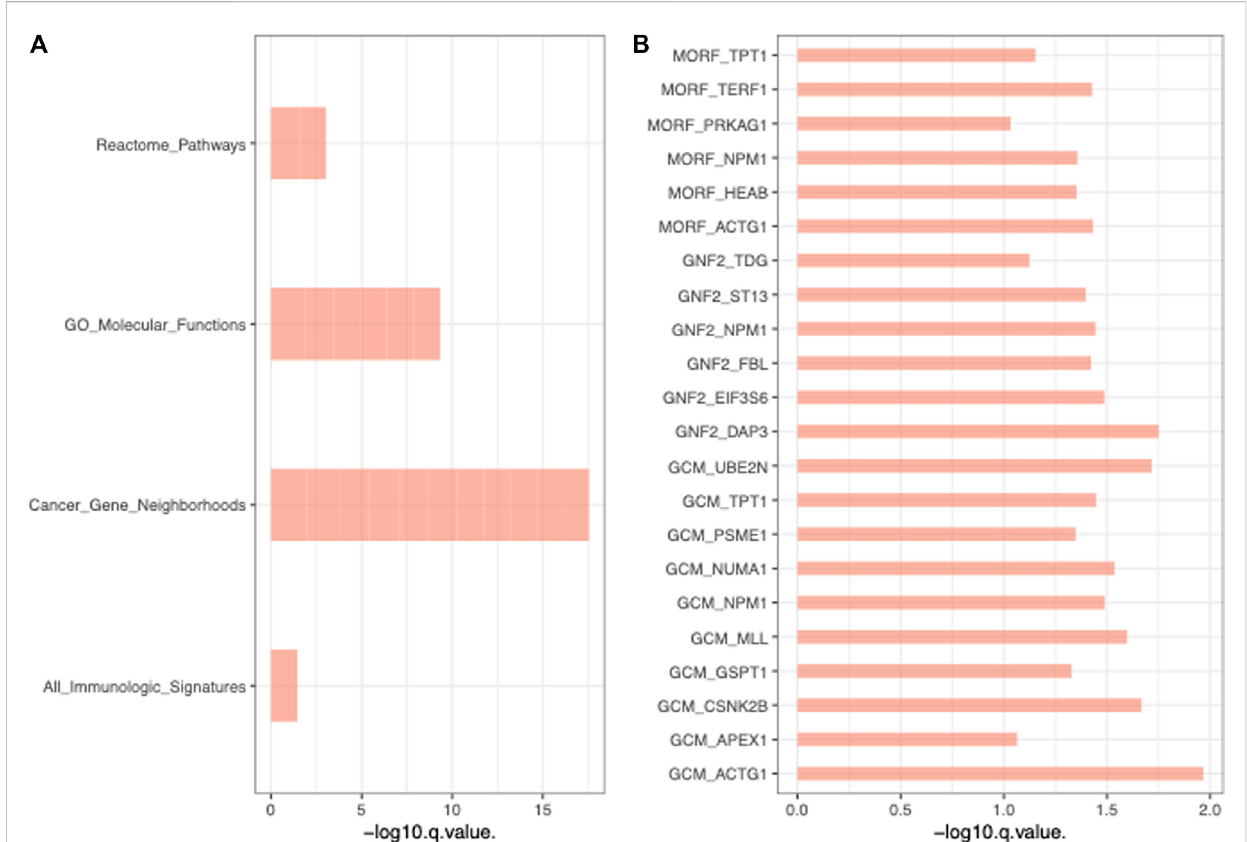
FIGURE 3 Functional Analysis of Signi fi cant mtio-ncRNAs Target Genes and Enriched Pathways. (A) Enriched pathways of all pathways, with Cancer Gene Neighborhoods pathway being the most signi fi cant. (B) The Cancer Gene Neighborhoods pathway, with GCM1 and ACTG1 as the two most signi fi cant genes in the